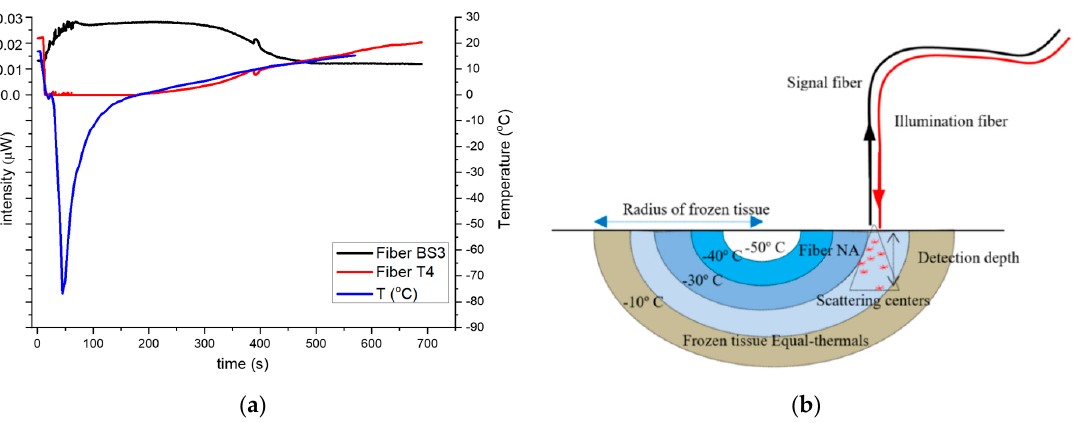
Figure 4. ( a ) Typical backscattering (black) and transmission intensities (red) and temperature (blue) timeline during freeze/thaw cycle for the illumination fiber near the surface of tissue depth x = 3.0 mm. ( b ) Sideview showing the fiber illumination cone and detection depth in the “ice hemisphere” of the tissue.